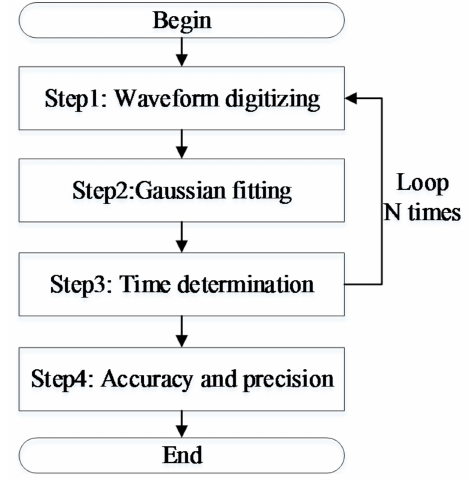
Figure 5. Flow chart of